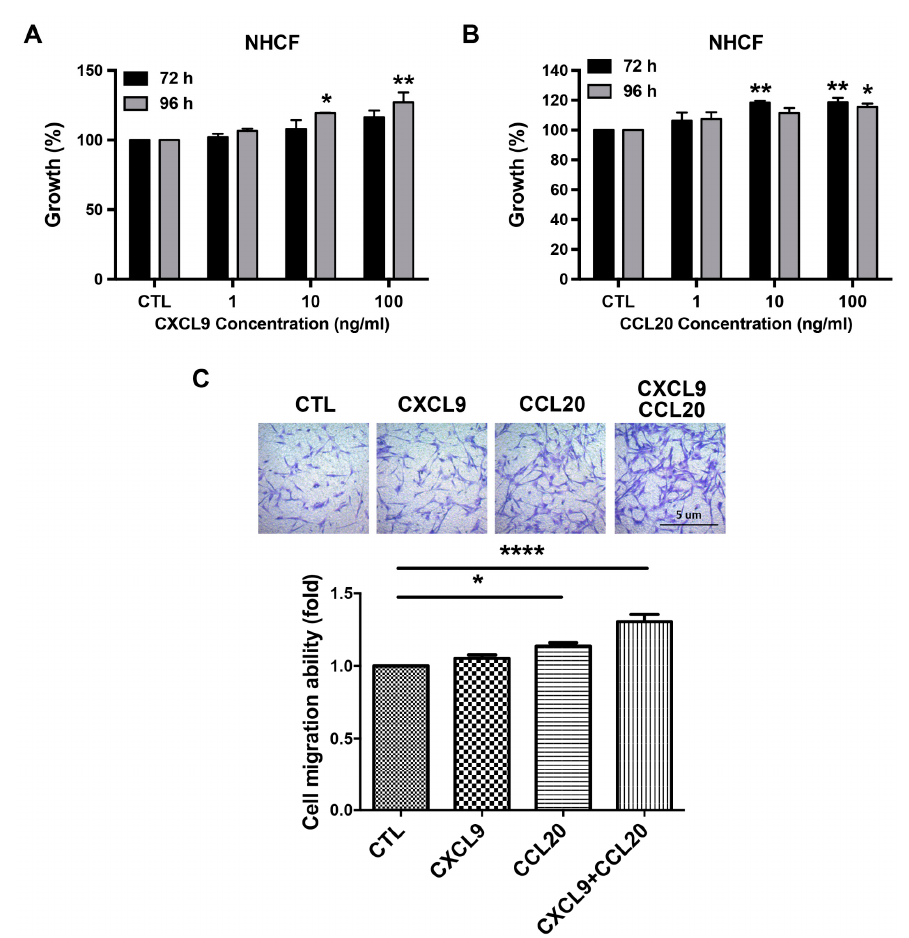
Figure 4. E ff ects of CXCL9 and CCL20 on the growth and migration of cardiac fibroblast. ( A ) A 96-hour incubation with CXCL9 (10 and 100 ng / mL) promoted the growth of NHCFs. ( B ) A 72-hour incubation with CCL20 (10 and 100 ng / mL), as well as a 96-hour incubation with CCL20 (100 ng / mL), promoted the growth of NHCFs. ( C ) CXCL9 and CCL20 promoted NHCFs migration. Detailed procedures are described in Materials and Methods. (Upper panel) Representative images of migrated NHCFs. (Lower panel) Quantitative results of the migration ability of NHCFs. CTL = control; NHCFs = Normal human cardiac fibroblasts. Each experiment was conducted at least 3 times independently. Results are presented as mean ±